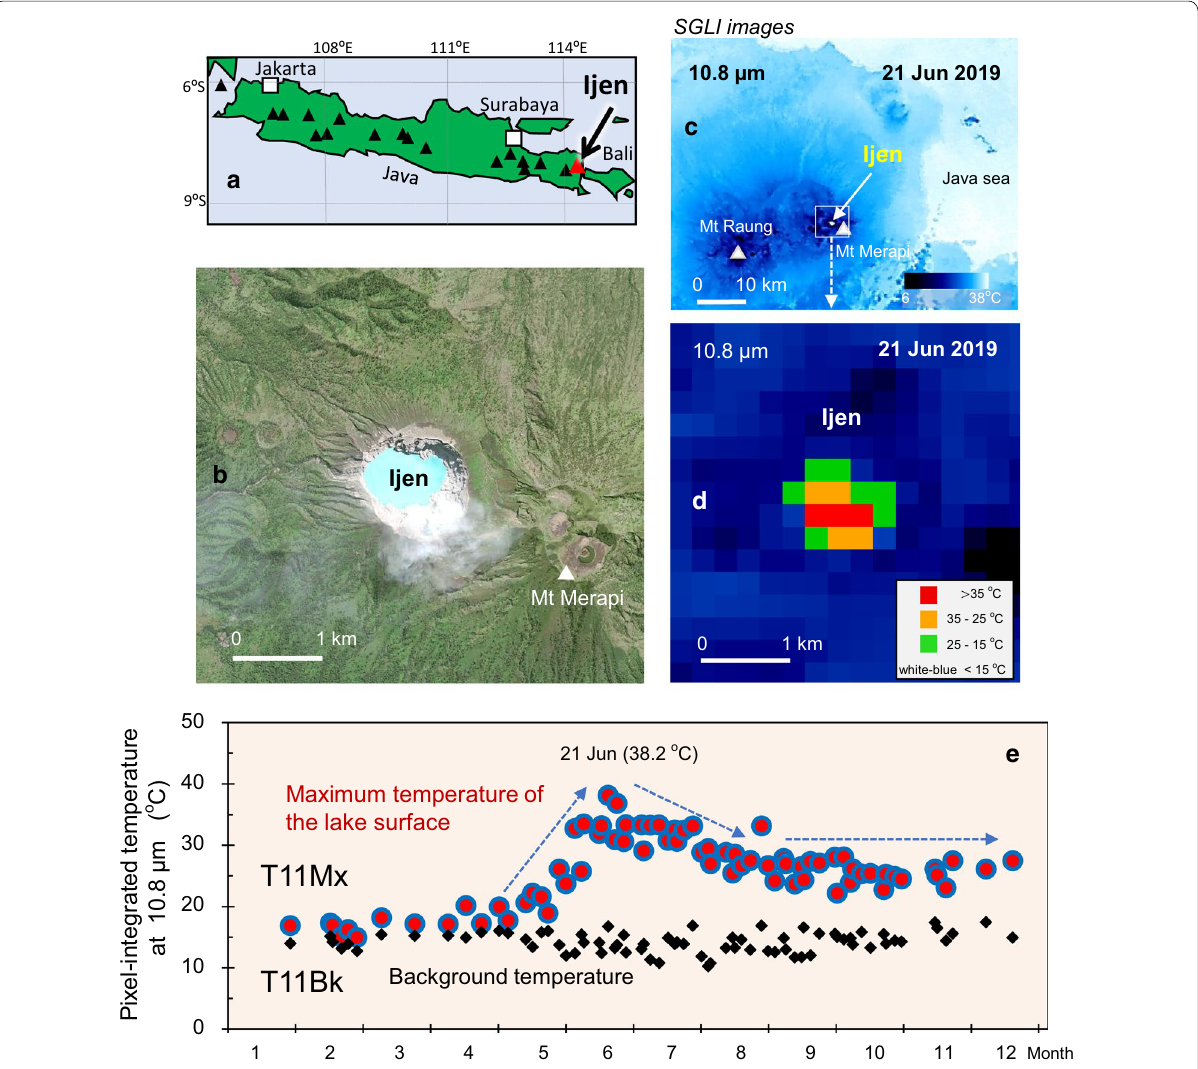
Fig. 5 a Location of Ijen. b Ijen and the surrounding areas (WorldView-2 image). c SGLI 10.8 µm image of 21 June 2019. The Ijen volcanic crater lake is found to be the hottest point in the image field. d Pixel-integrated temperature images of the SGLI 10.8 µm band in the vicinity of the Ijen volcanic crater lake on 21 June. e Time-series variations of thermal anomalies (T11Mx and T11Bk) detected by the 10.8 µm band of SGLI between January and December